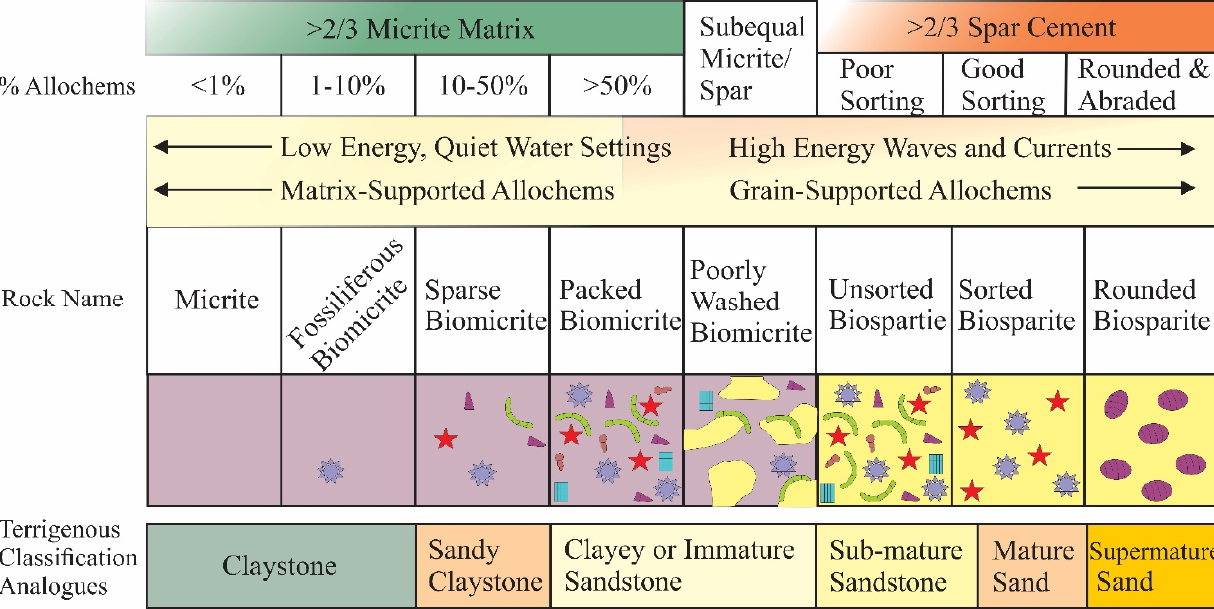
Figure 2. Folk classification of limestones based on textural parameters and implied depositional conditions.